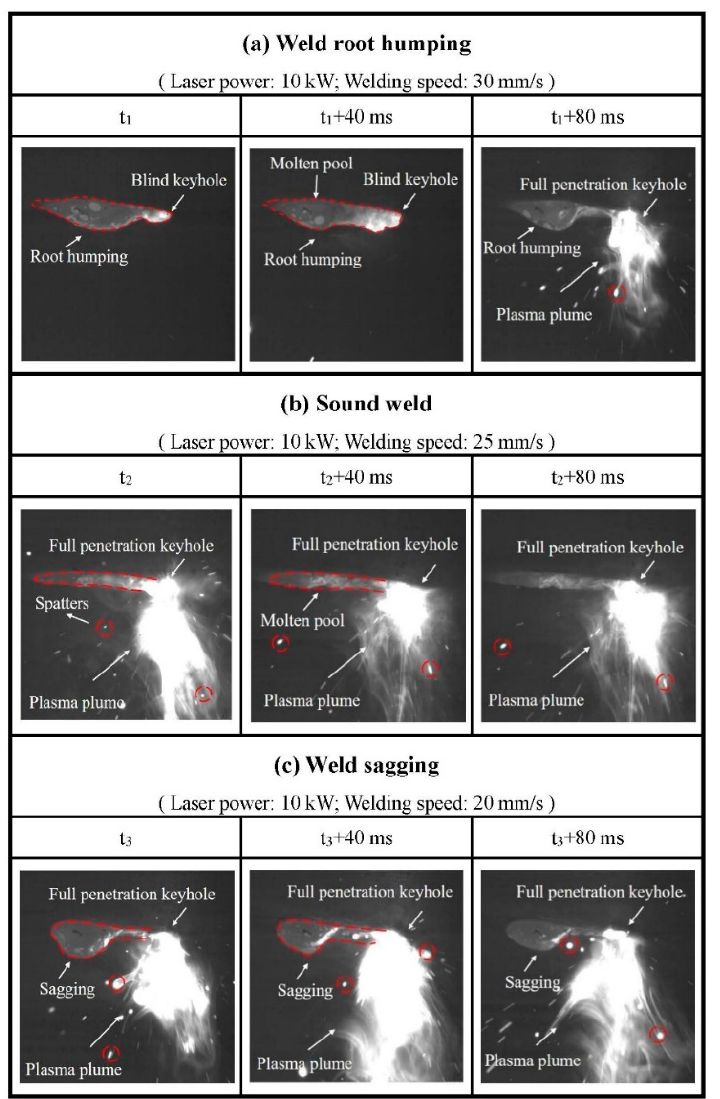
Figure 6. High-speed camera observation results of bottom molten pool behaviors for different types of weld-root defects.